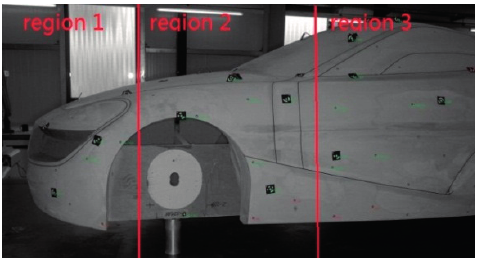
Figure 3. Measuring the distance between region 1 and region